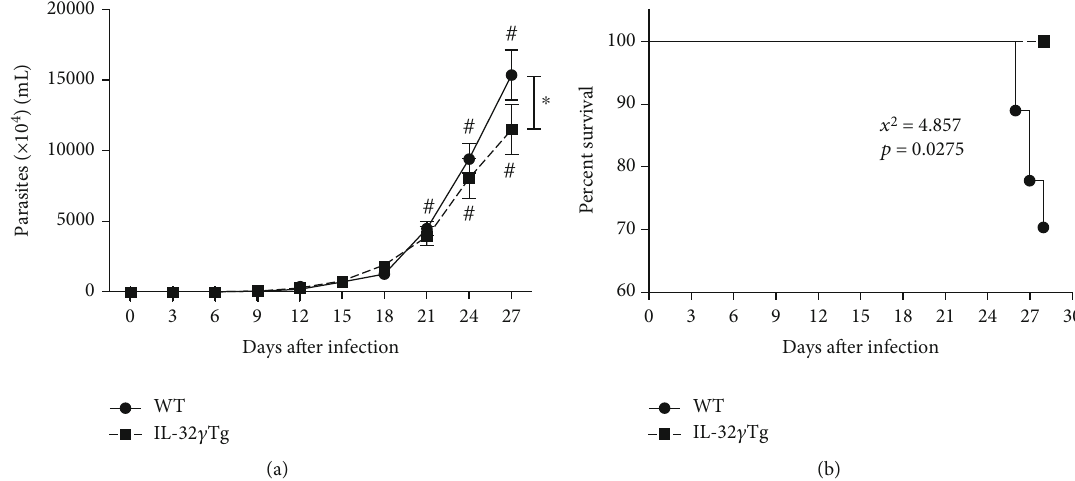
Figure 1: Interleukin-32 γ controls parasitemia and protects mice in the acute phase of Chagas disease. WT and IL-32 γ Tg mice were subcutaneously infected with 1,000 blood trypomastigote forms of T. cruzi Colombian strain. (a) Parasitemia was determined by counting the number of trypomastigotes in blood collected from the caudal vein. # p < 0 : 05 (di ff erences within the same group, comparing fi rst day with detectable parasitemia vs. the time point observed) and ∗ p < 0 : 05 (WT vs. IL-32 γ Tg mice). Signi fi cant statistical di ff erences at p < 0 : 05 , two-way ANOVA with Bonferroni post hoc test. (b) Percent survival of infected IL-32 γ Tg and WT mice, p = 0 : 0275 , Log-Rank test.